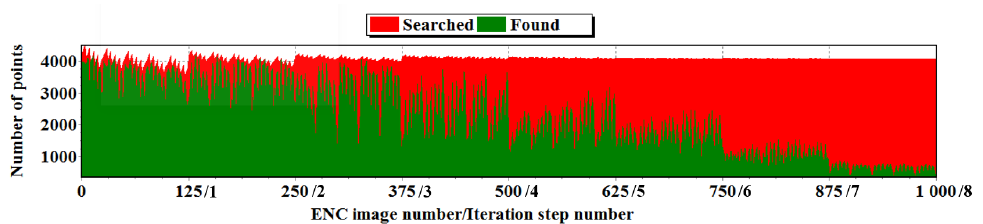
Figure 13. Graphs of the arithmetic mean and standard deviation dmin during the iteration process for photograph No. 5.